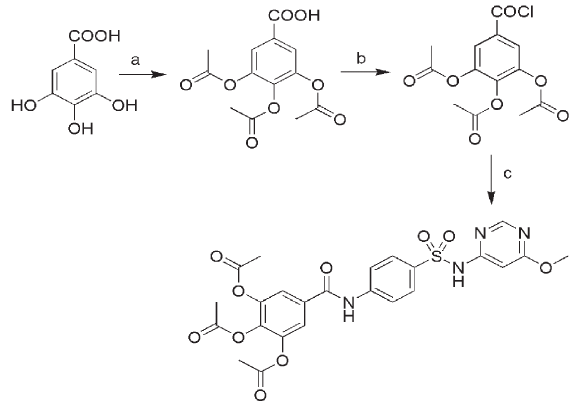
Figure 1. Schematic route and procedures for the synthesis of JJYMD-C. Reagents and conditions: (a) acetyl oxide, oil bath, 120 6 C; (b) SOCl 2 , oil bath, 80 6 C; (c) sulfamonomethoxine sodium, tetrahydrofuran, pyridine, ice bath (0 6